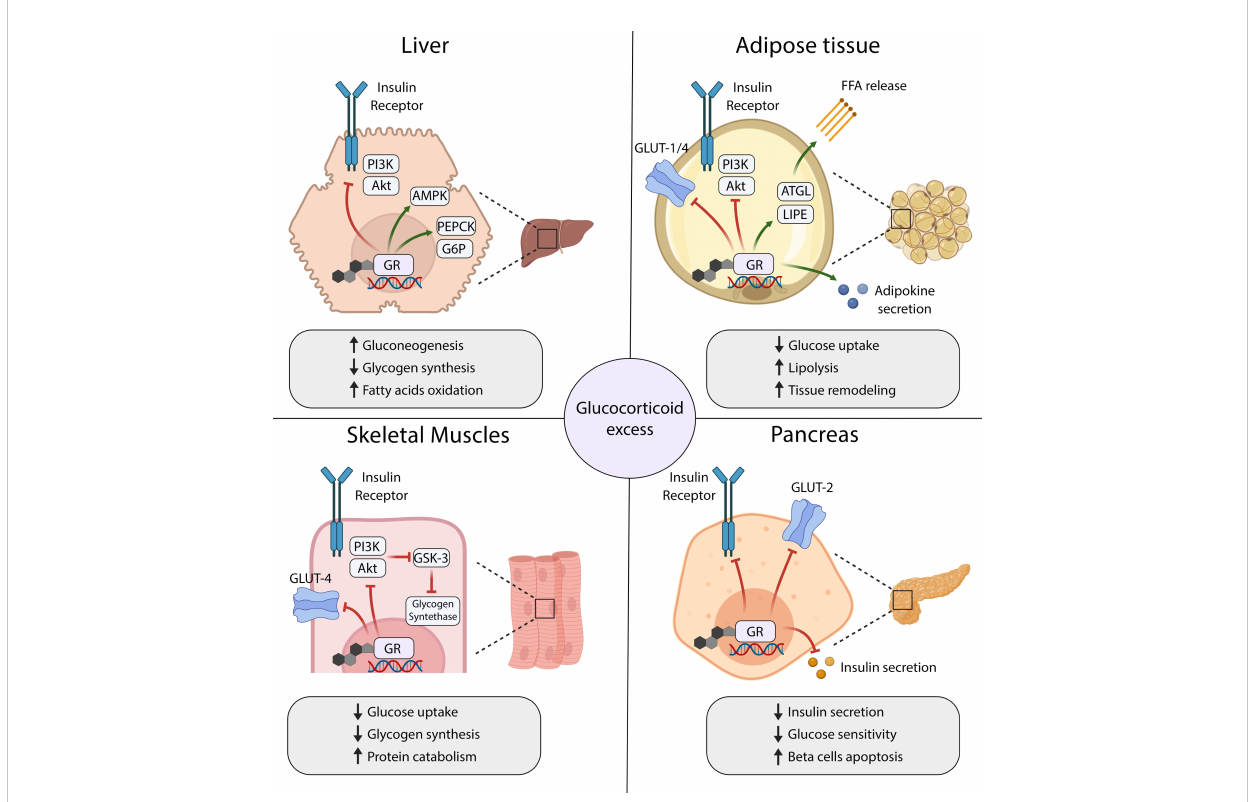
FIGURE 1 Mechanisms of glucocorticoid-induced insulin resistance and diabetes mellitus in main organs that control glucose homeostasis. GR, Glucocorticoid Receptor; FFA, free fatty acids; ATGL, Adipose triglyceride lipase; LIPE, lipase,